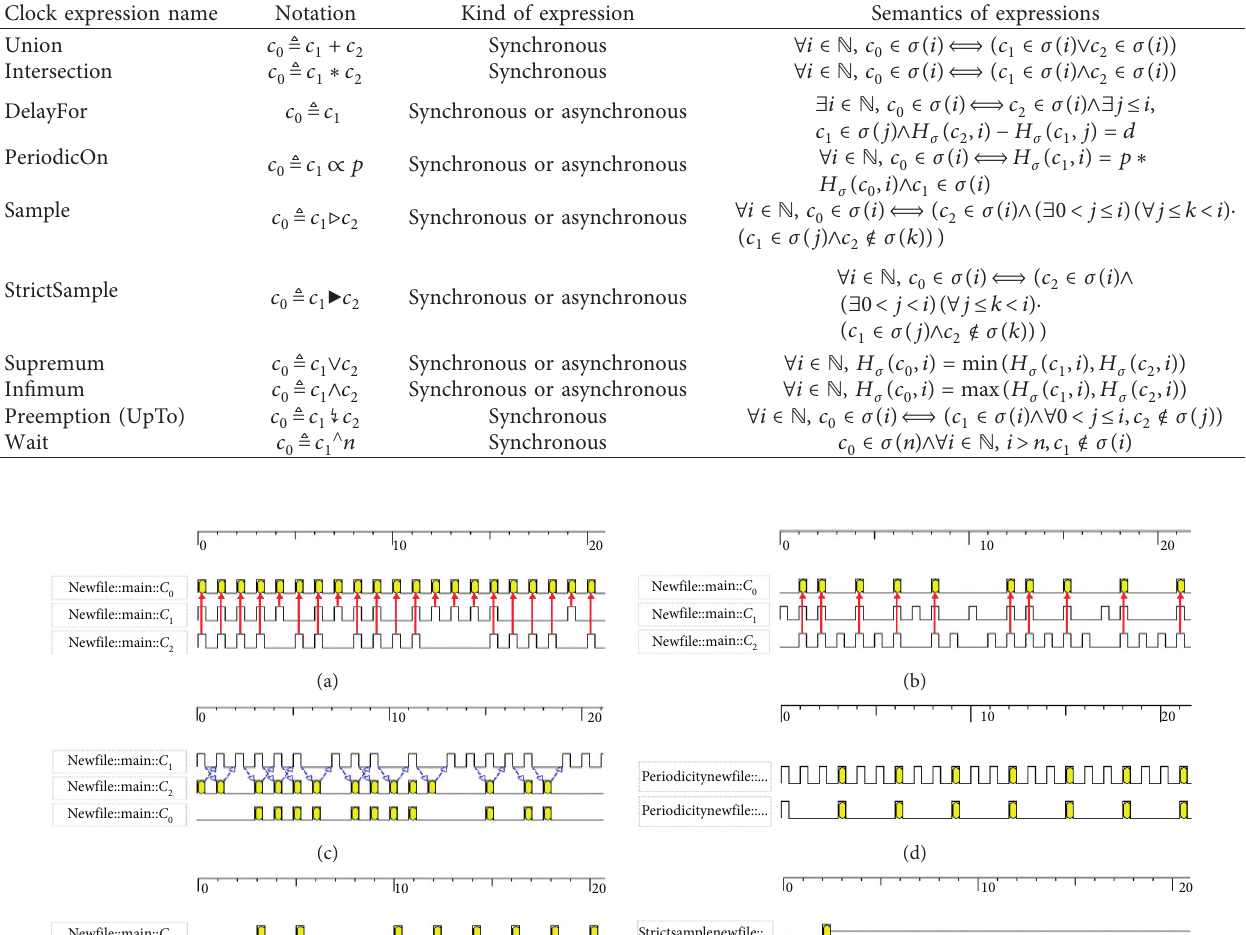
Table 2: The semantics of clock